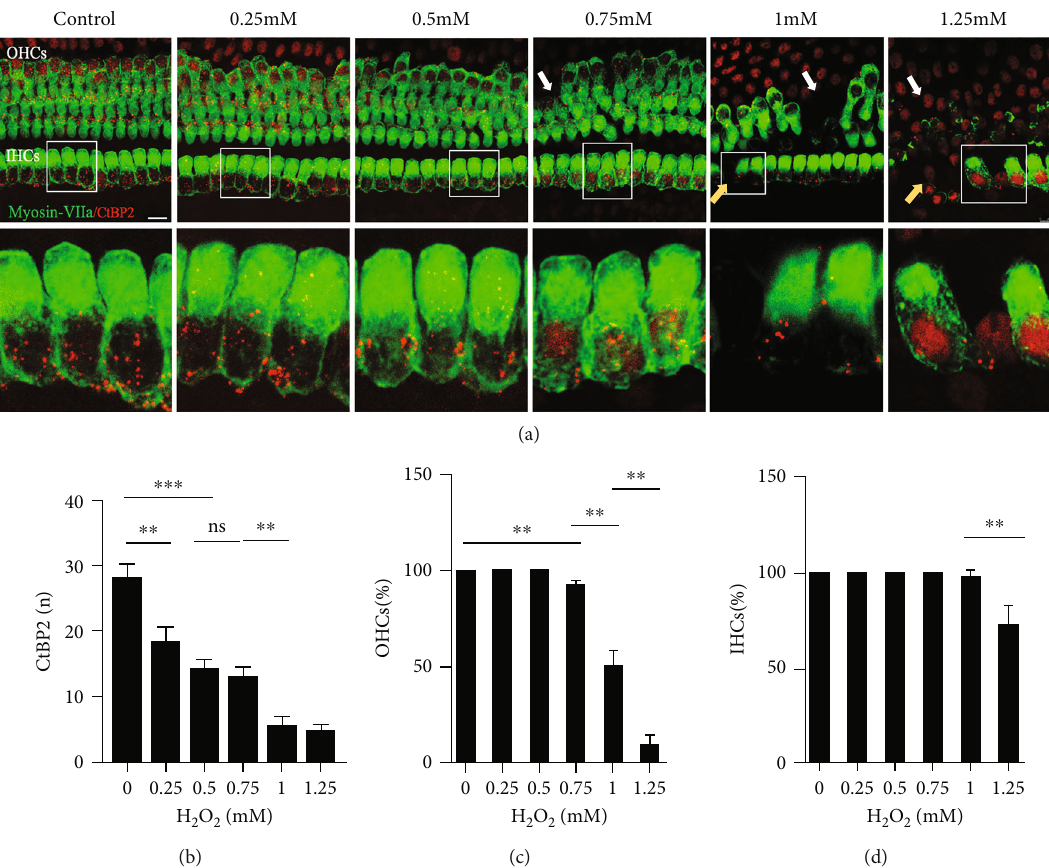
Figure 1: H O induces dose-dependent loss of ribbon synapses and hair cells at the 0, 0.25, 0.5 0.75, 1, and 1.25mM concentrations. 2 2 (a) Confocal images showing ribbon synapses (red) and hair cells (green) in the middle region of cochlear explants at each concentration. The white arrows indicate OHC damaged areas. Yellow arrows indicate IHC damaged areas. (b) Quanti fi cation of ribbon synapses at each concentration. (c) Rate of OHC survival at each concentration. (d) Rate of IHC survival at each concentration. Data are expressed as means ± SD ( n = 5 organ of Corti per concentration). ∗ P < 0 : 05 , ∗∗ P < 0 : 01 , and ∗∗∗ P < 0 : 001 . Scale bar = 10 μ